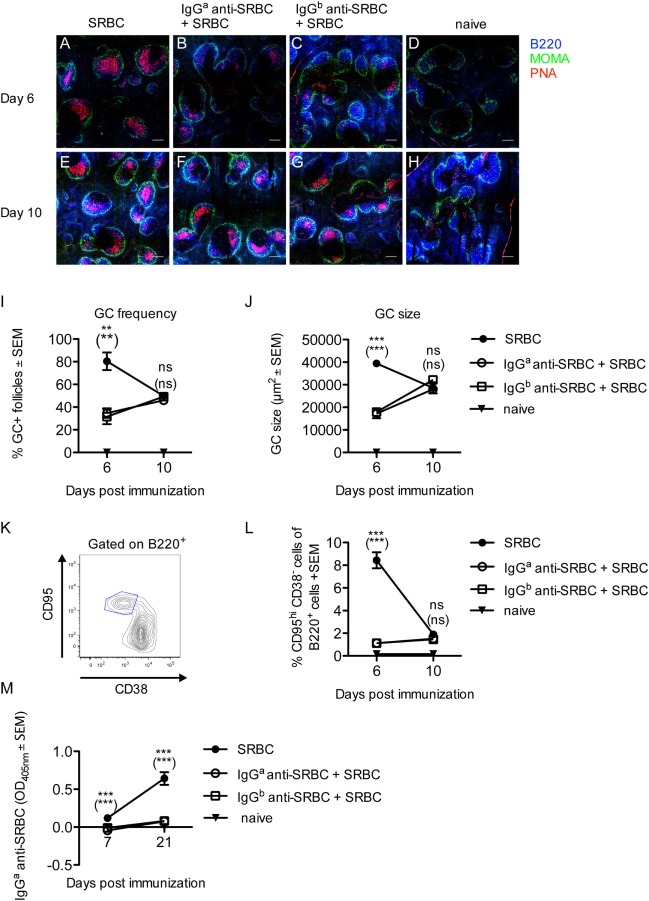
Development of germinal centers (GCs) but suppression of sheep red blood cells (SRBC)-specific antibody responses in mice immunized with syngeneic or allogeneic IgG anti-SRBC together with SRBC. BALB/c mice were immunized with 10 µg syngeneic IgGa anti-SRBC (open circles) or 10 µg allogeneic IgGb anti-SRBC (open squares) 30 min prior to immunization with 5 × 106 SRBC. Controls were immunized with 5 × 106 SRBC alone (filled circles) or left unimmunized (filled triangles). On days 6 and 10 after immunization, spleens were harvested. Half of each spleen was processed for analysis of GC B-cells by confocal laser scanning microscopy, and the other half for flow cytometry. (A–H) Representative 2,000 µm × 2,000 µm areas of tile scans of spleen sections. Visualization of GCs in the spleen: B220+ (blue), MOMA+ metallophilic macrophages (green), and PNA+ GCs (red) (n = 3/group). Scale bar is 200 µm. (I) Average percentage of follicles containing PNA+ GCs of total number of follicles. (J) Average size of PNA+ areas in the GCs in one spleen section per mouse (10–40 GCs/section were measured) quantified as the area in square micrometers for each group. (K) Representative contour plot for flow cytometric analysis of GC B-cells. (L) GC B-cells gated as CD95hiCD38− of B220+ lymphocytes (n = 3/group). (M) The IgGa anti-SRBC response was followed in mice from each group for 7–21 days after immunization (n = 5/group, n = 2 for negative controls). Sera diluted 1:625 were screened for IgGa anti-SRBC in enzyme-linked immunosorbent assay. p-Values for comparisons of mice immunized with IgGa anti-SRBC and SRBC versus SRBC alone are given without parentheses. Comparisons of mice immunized with IgGb anti-SRBC and SRBC versus SRBC alone are given in parentheses. Data are representative of three (A–J), at least four (K,L), or two independent experiments/IgG allotype (M) (ns, p > 0.05; *p < 0.05; **p < 0.01; ***p < 0.001).